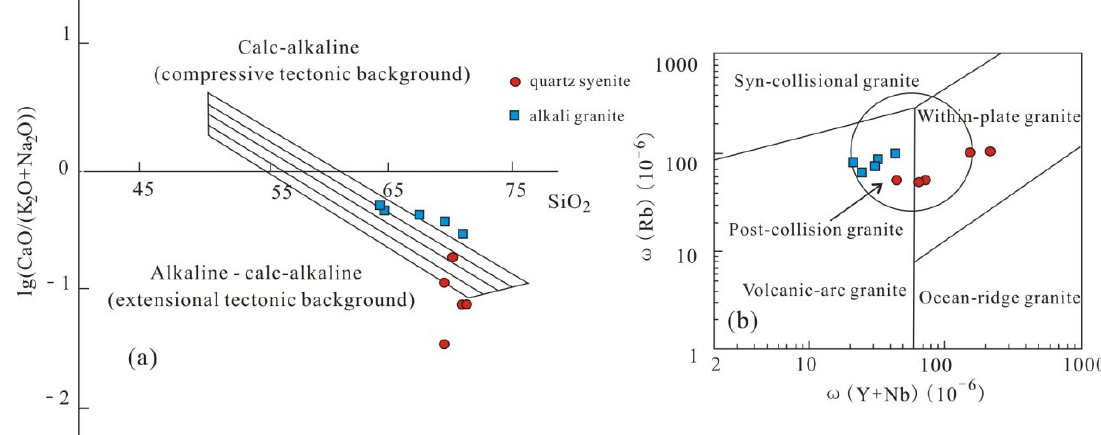
Figure 10. lg(CaO/(Na 2 O+K 2 O)) − SiO 2 ( a ) and Rb – (Y + Nb) ( b ) discrimination diagrams of the Figure10. lg(CaO / (Na 2 O + K 2 O)) − SiO 2 ( a )andRb − (Y + Nb)( b )discriminationdiagramsoftheChishan Chishan alkaline complex. (a) is from [75], (b) is from [76]. alkaline complex. ( a ) is from [75], ( b ) is from